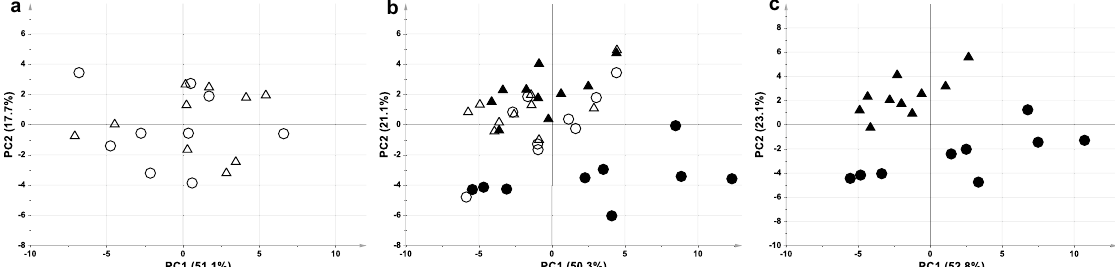
Figure 1. PCA score plot of ACA and VFCA plasma samples ( a ) at baseline (A = 3, Par, R 2 = 0.81, Q 2 = 0.59), ( b ) at baseline vs. the 5th minute of untreated CA (A = 3, Par, R 2 = 0.83, Q 2 = 0.68), and ( c ) at the 5th minute of untreated CA (A = 3, Par, R 2 = 0.86, Q 2 = 0.67). ACA samples are represented by open circles at baseline and black circles at arrest. VFCA samples are represented by open triangles at baseline and black triangles at arrest.